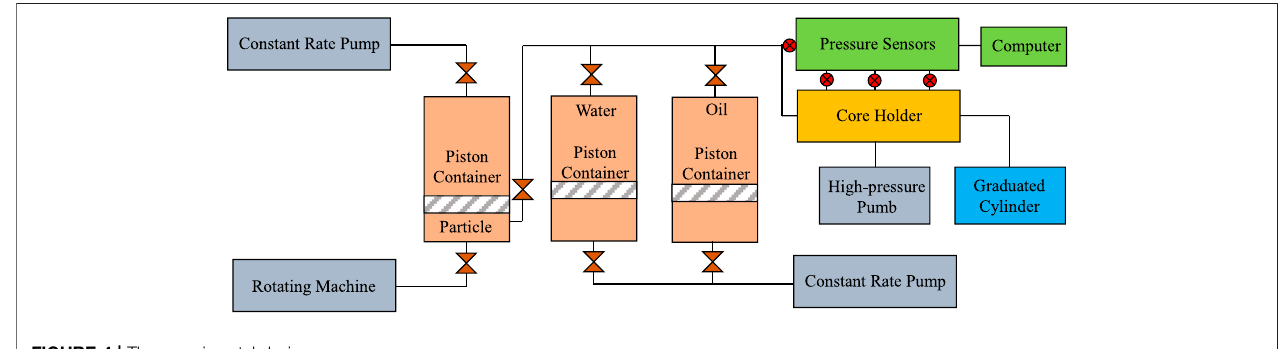
FIGURE 4 | The experimental devices.